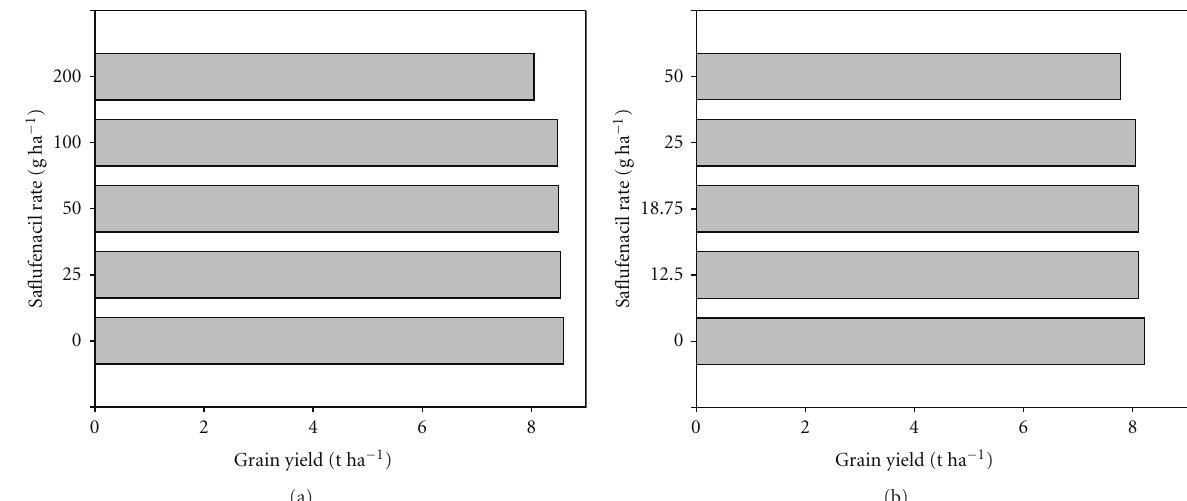
Figure 2: Grain yield (tha − 1 ) in response to preemergence (a) and postemergence (b) application of saflufenacil following preemergence application of clomazone. Data were averaged across clomazone rates. Means were not di ff erent according to F-test at P ≤